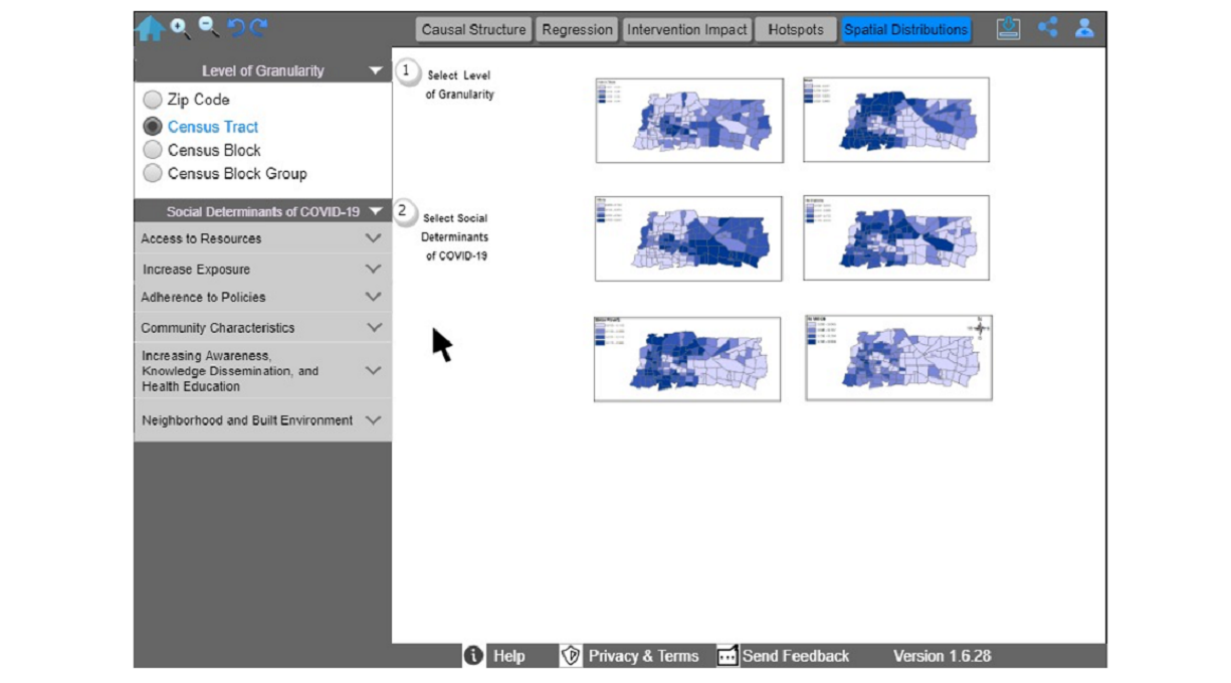
Figure 6. Spatial distribution of administered COVID-19 tests and Social Determinants of Health.